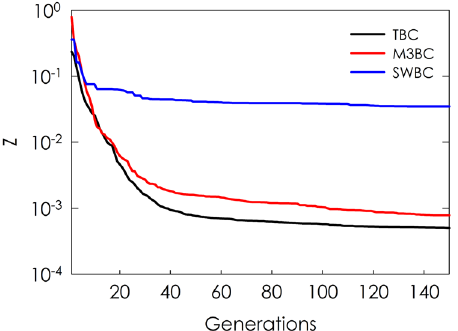
Fig. 1 Average Z value convergence with generations. Each line in this fi gure represents the average Z value (Eq. 1) per generation, across all 100 trials performed on the TBC, M3BC, and SWBC potentials. The following weights were used for each Z component: w f = 0.15, w e = 0.25, w s = 0.2, w ifc − 2 = 0.2, and w ifc − 3 = 0.2. This type of analysis shows that some functional forms are able to simulta- neously reproduce certain properties better than others. The SWBC, which on average only experienced an order of magnitude decrease from a random guess in Z , could not reproduce all quantities at once. The TBC and M3BC potentials were able to decrease Z by 3 orders of magnitude from a random guess. The small fi nal discrepancy between TBC and M3BC is due to the fact that TBC better reproduced the 3rd order IFCs, which also led to better thermal conductivity agreement as seen with Figs. 2 and